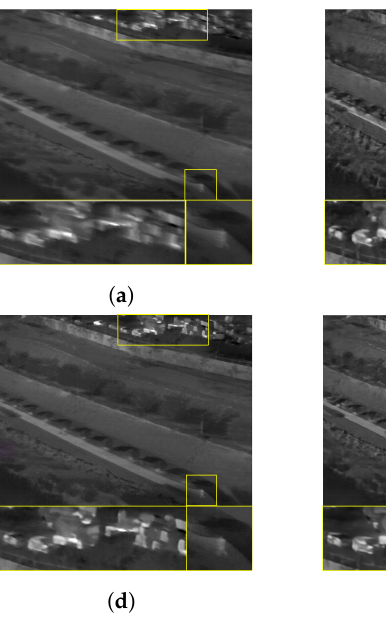
Figure 17. Qualitative comparison of motion deblurring results on the real blurry thermal image.